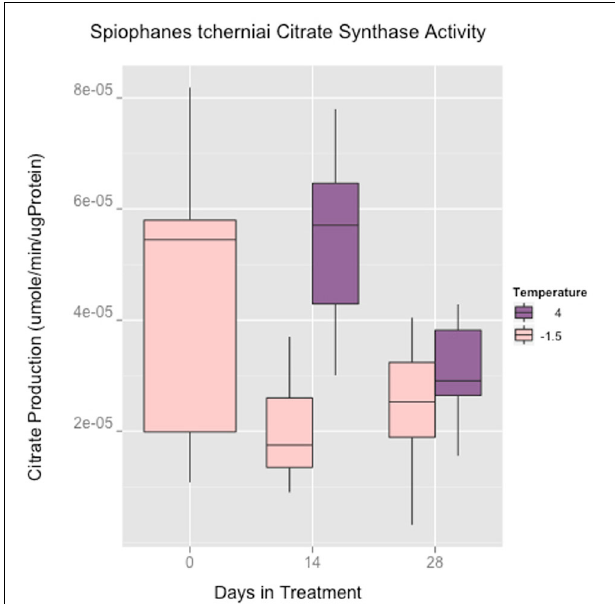
FIGURE 2 | Spiophanes tcherniai maximum catalytic rates of citrate synthase normalized to protein mass in worms maintained for 4 weeks at − 1.5 ◦ C and + 4 ◦ C.